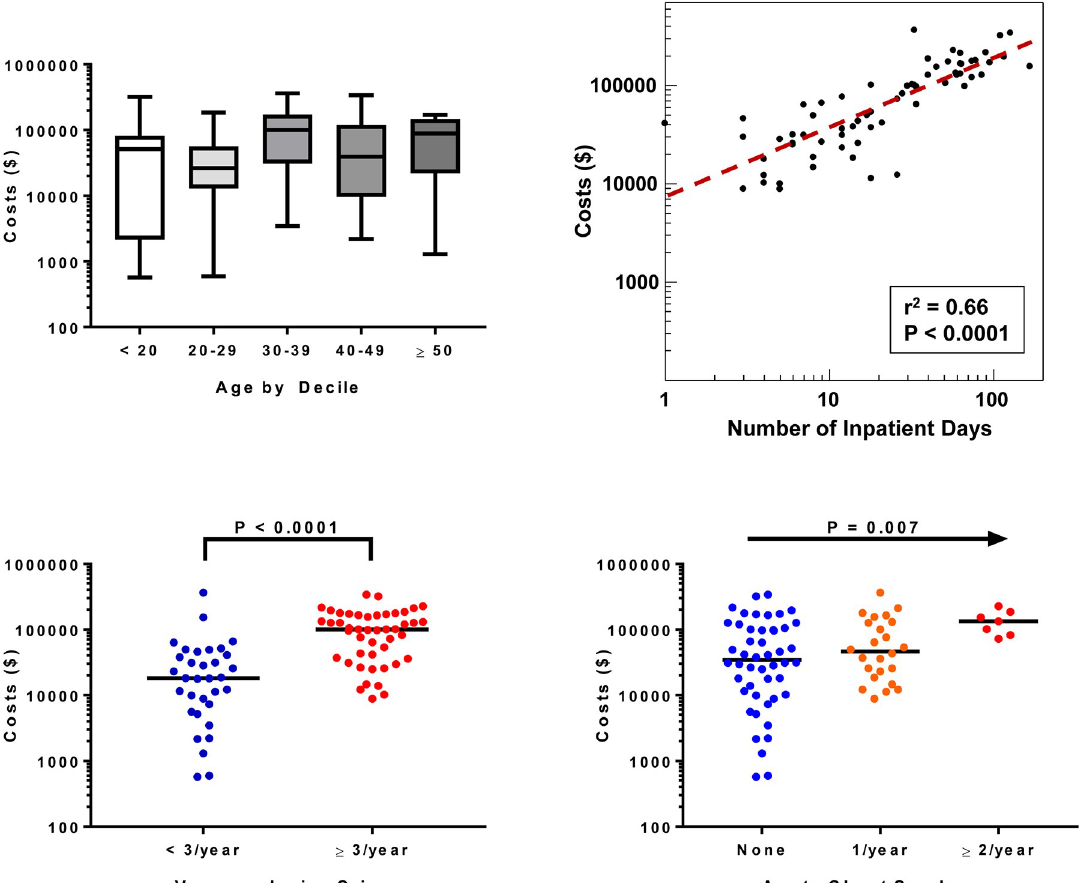
Fig 1. Clinical variables associated with health care costs in 83 patients with sickle cell disease in the year prior to evaluation for HSCT.